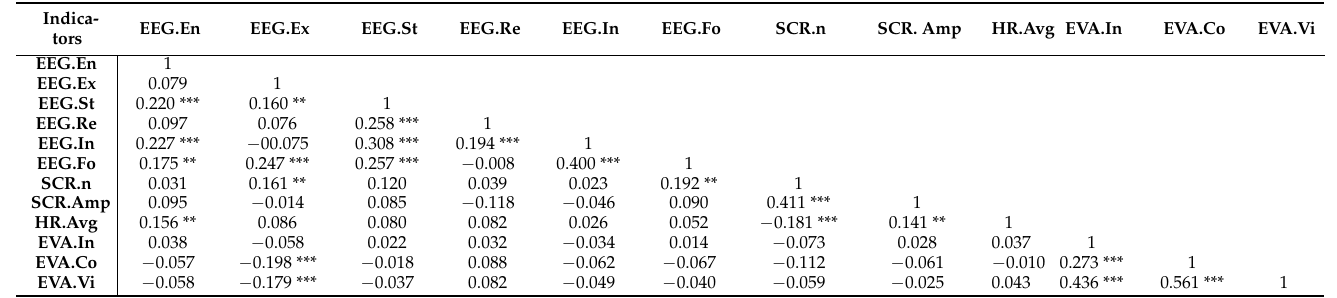
Table 8. The correlation coefficient of the multi-dimensional perception